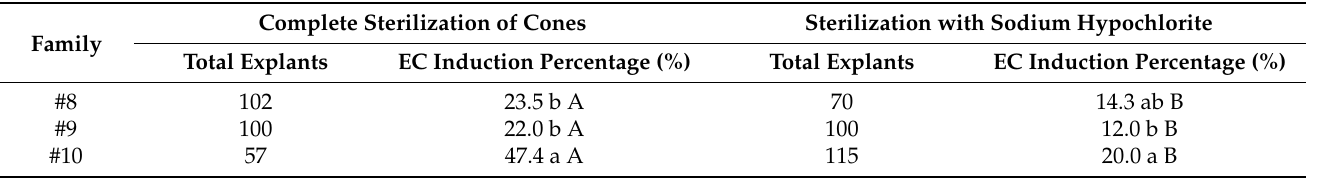
Table 1. Effects of sterilization methods of cones on EC induction percentage of Korean pine.